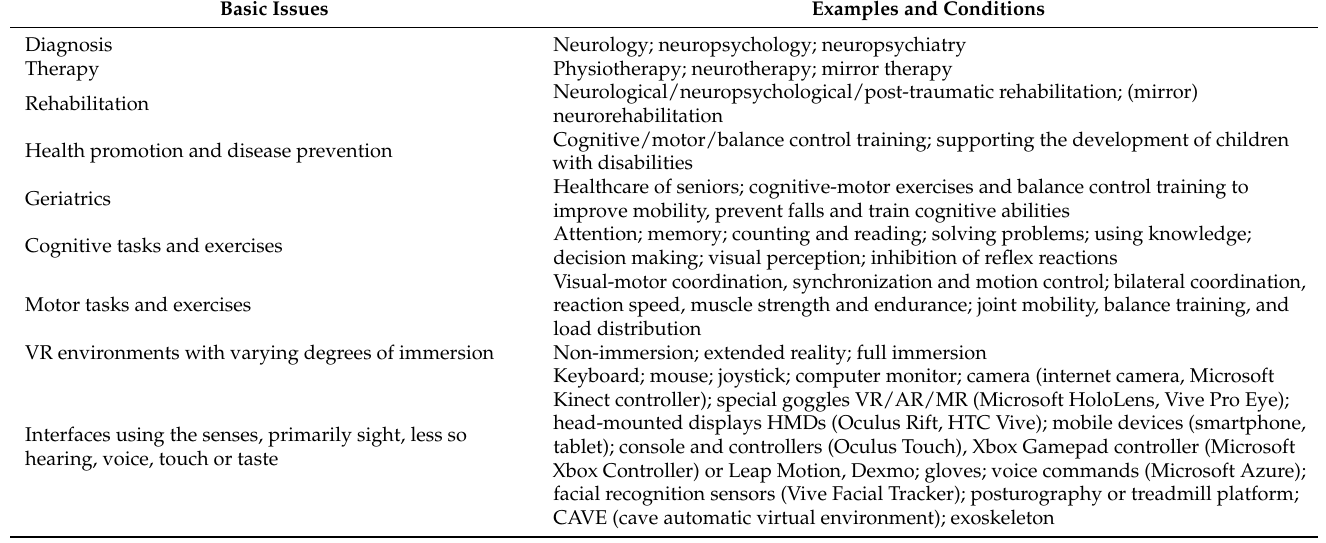
Table 2. The summary of VR applications and equipping virtual environments used in basic and clinical